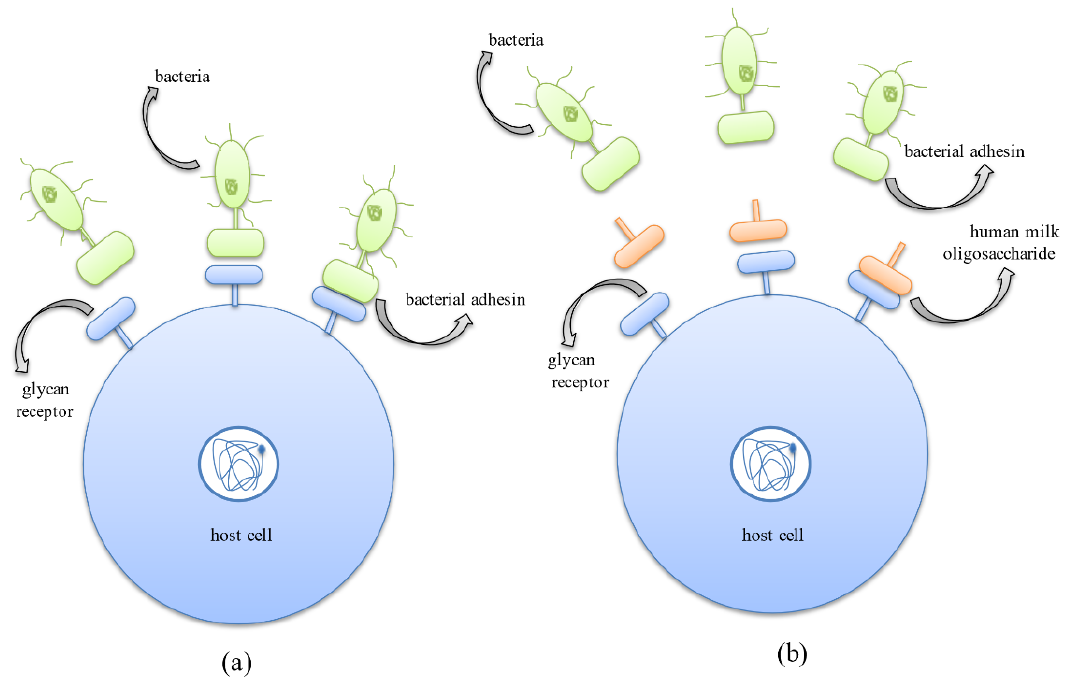
Figure 6. Anti-adhesive mechanism exhibited by human milk oligosaccharides where they compete with bacterial protein adhesins for binding to host cell surface glycan receptors. ( a ) Binding of bacterial protein adhesins to the host cell surface glycan receptors aiding successful colonization in the host system. ( b ) Binding of HMOs to host cell surface receptors thus inhibiting adhesion of bacteria to host cells and successfully preventing the occurrence of